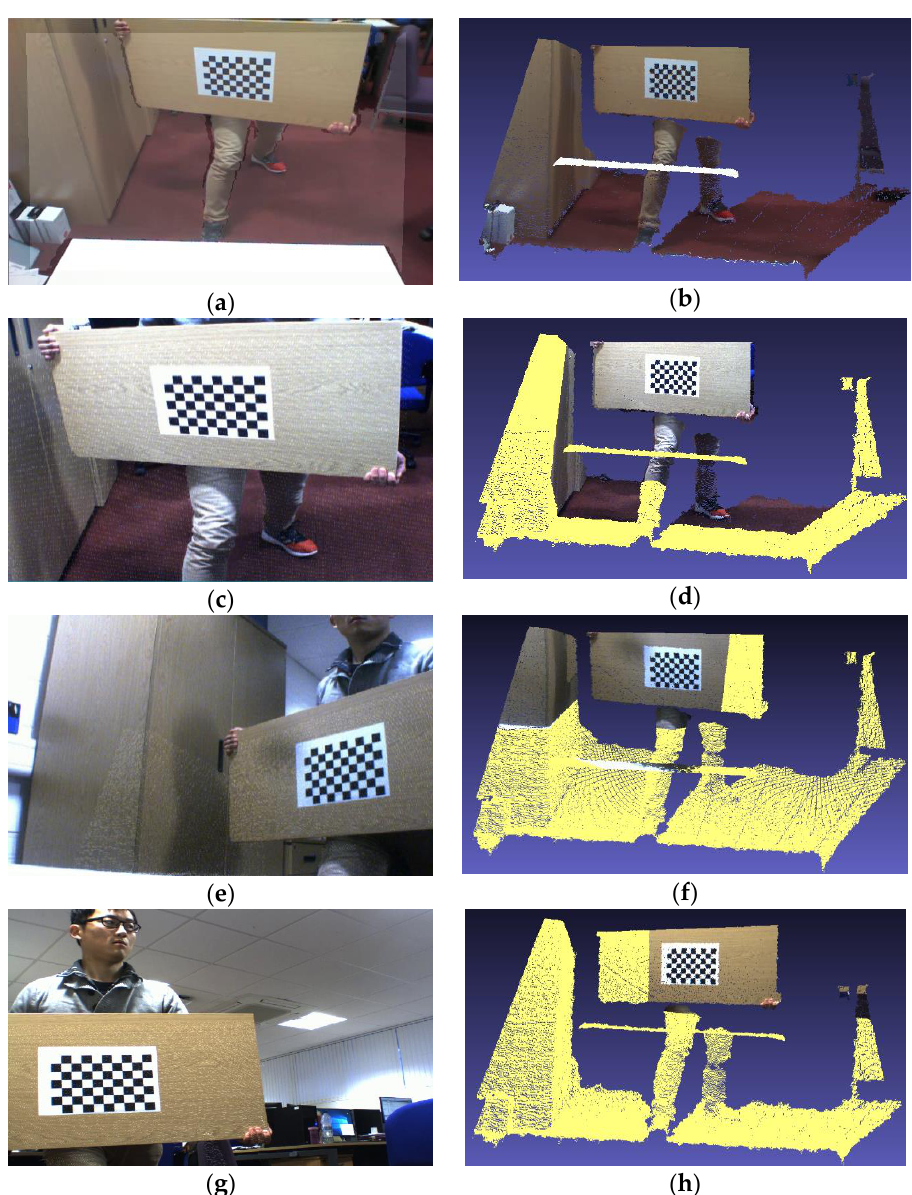
Figure 7. The overlaid depth maps and the corresponding 3D colored point cloud images obtained by Herrera’s method. ( a ) the color image is captured by the color camera in Kinect; ( c ), ( e ), ( g ) the color images are captured by the external camera 0, 1 and 2, respectively; ( b ), ( d ), ( f ), ( h ) are the corresponding 3D colored point cloud images, they are captured from ( a ), ( c ), ( e ), ( g ), respectively.